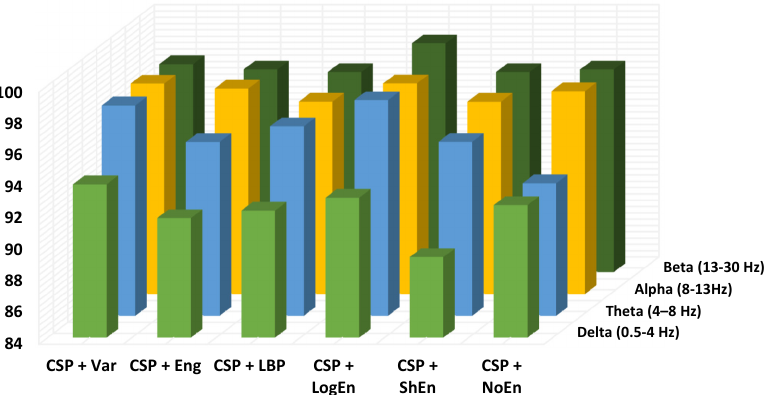
Figure 7. Classification accuracy of different EEG frequency bands using KNN (off–PD vs. HC). Table 6. Effect of frequency bands on classification accuracy using KNN (off–PD vs. HC).